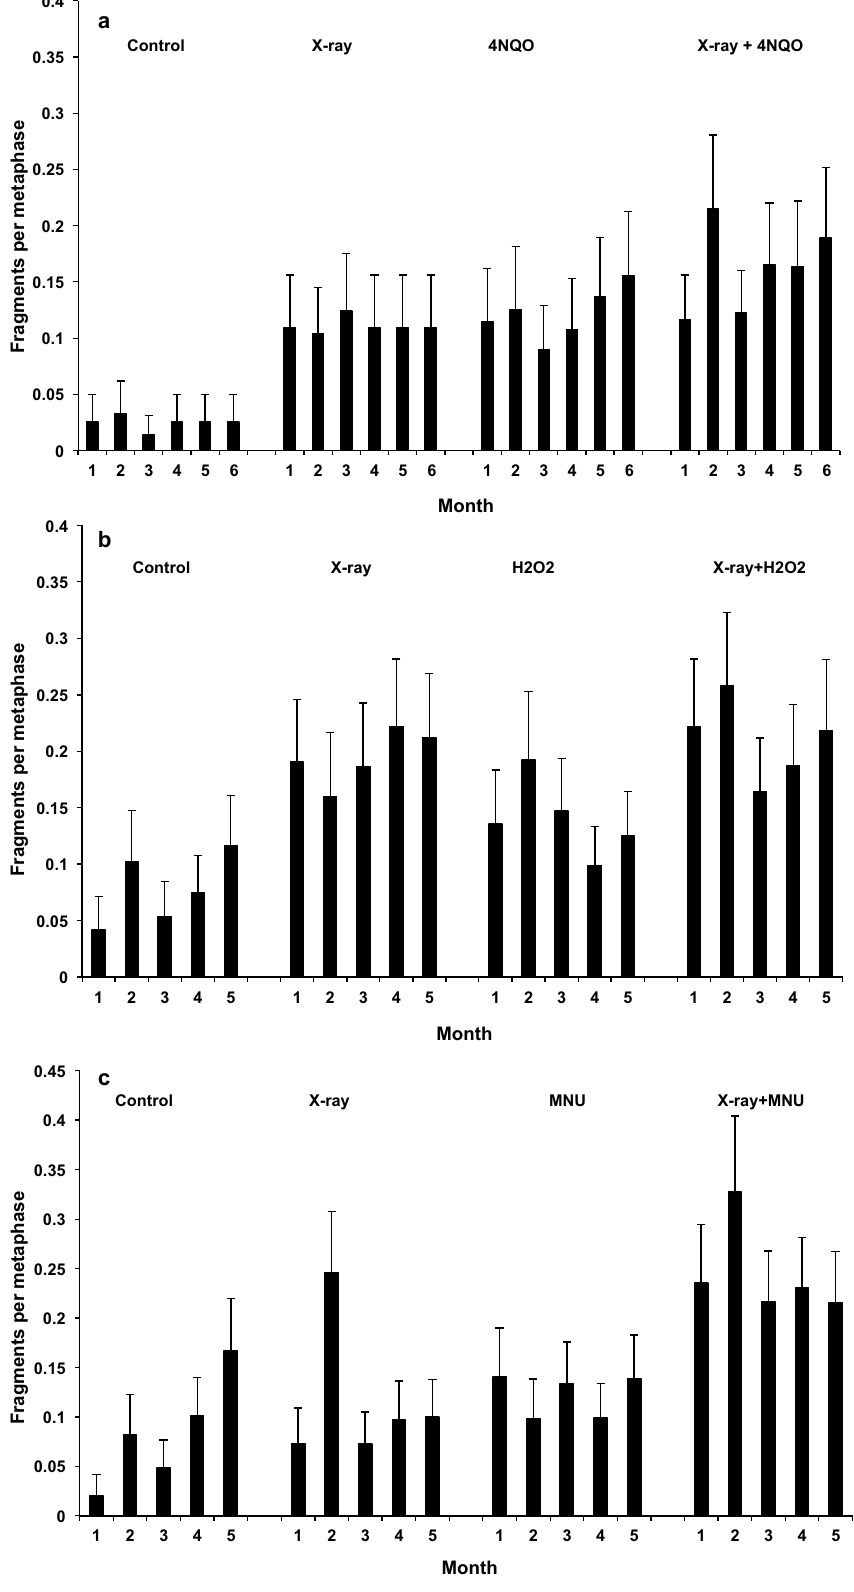
Figure 6. Acentric fragments per diploid metaphase after 1–6 months of chronic exposure to: 20 ng/ml 4NQO or sham-exposure and/or acute exposure to 1 Gy X-rays ( a ); 10 μM H 2 O 2 or sham-exposure and/or acute exposure to 1 Gy X-rays ( b ); 0.25 μg/ml MNU or sham-exposure and/or acute exposure to 1 Gy X-rays ( c ). Error bars are Poisson